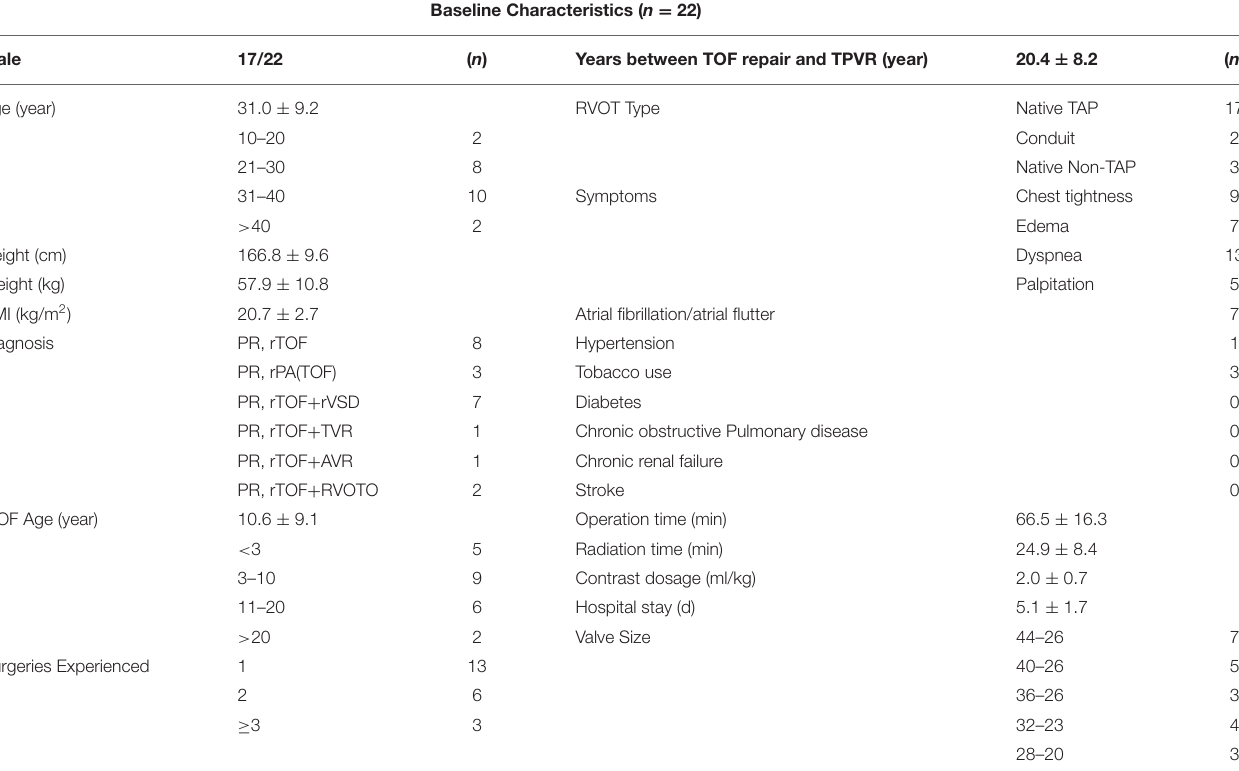
TABLE 1 | Baseline